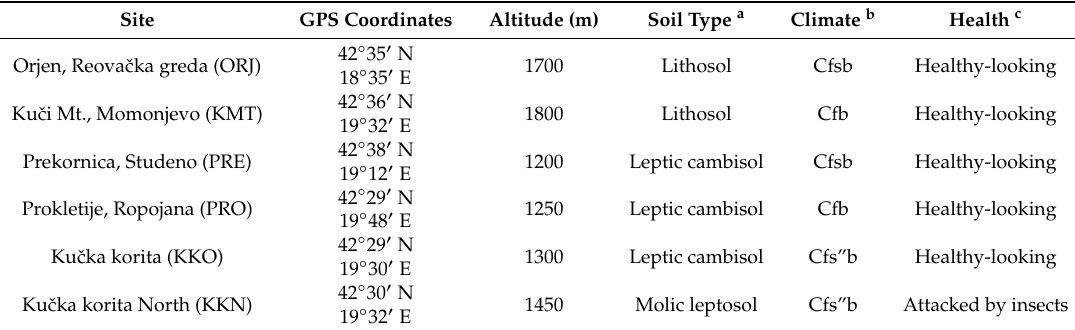
Table 1. Characteristics of Pinus heldreichii sampling sites.